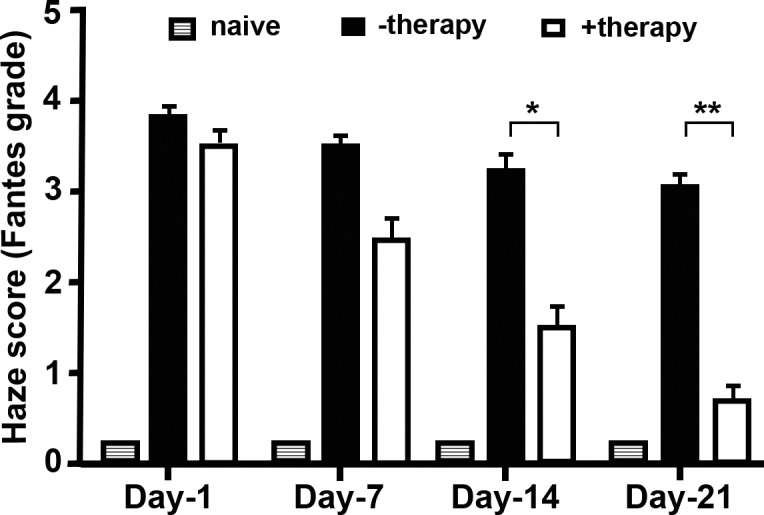
Quantification of corneal opacity using the Fantes score in the three groups of rabbits: no corneal injury group (naive; gray bar), PEI2-GNP-naked plasmid group (−therapy; black bar), and PEI2-GNP–BMP7+HGF group (+therapy; white bar). The graph depicts comparative haze scores 24 hours post injury and at days 7, 14, and 21 post injury (*P < 0.01 and **P < 0.001).